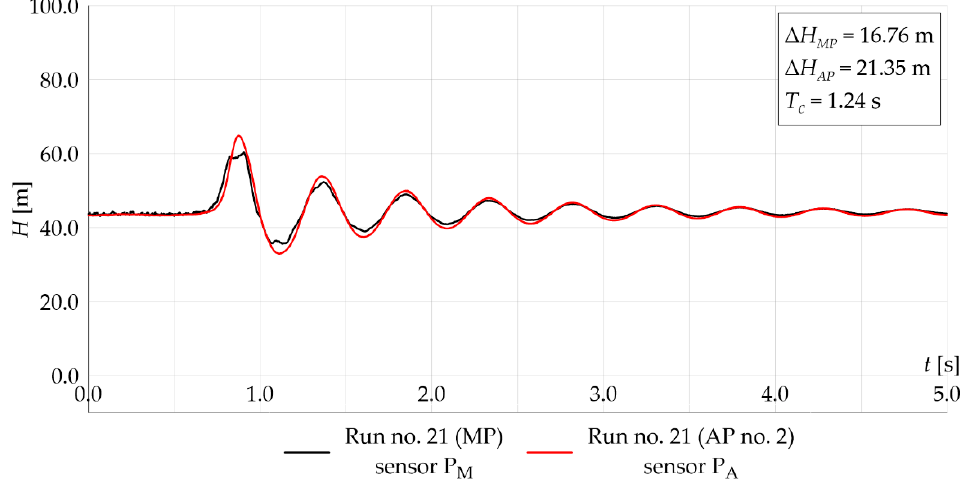
Figure 12. Pressure oscillations observed during run no. 21.